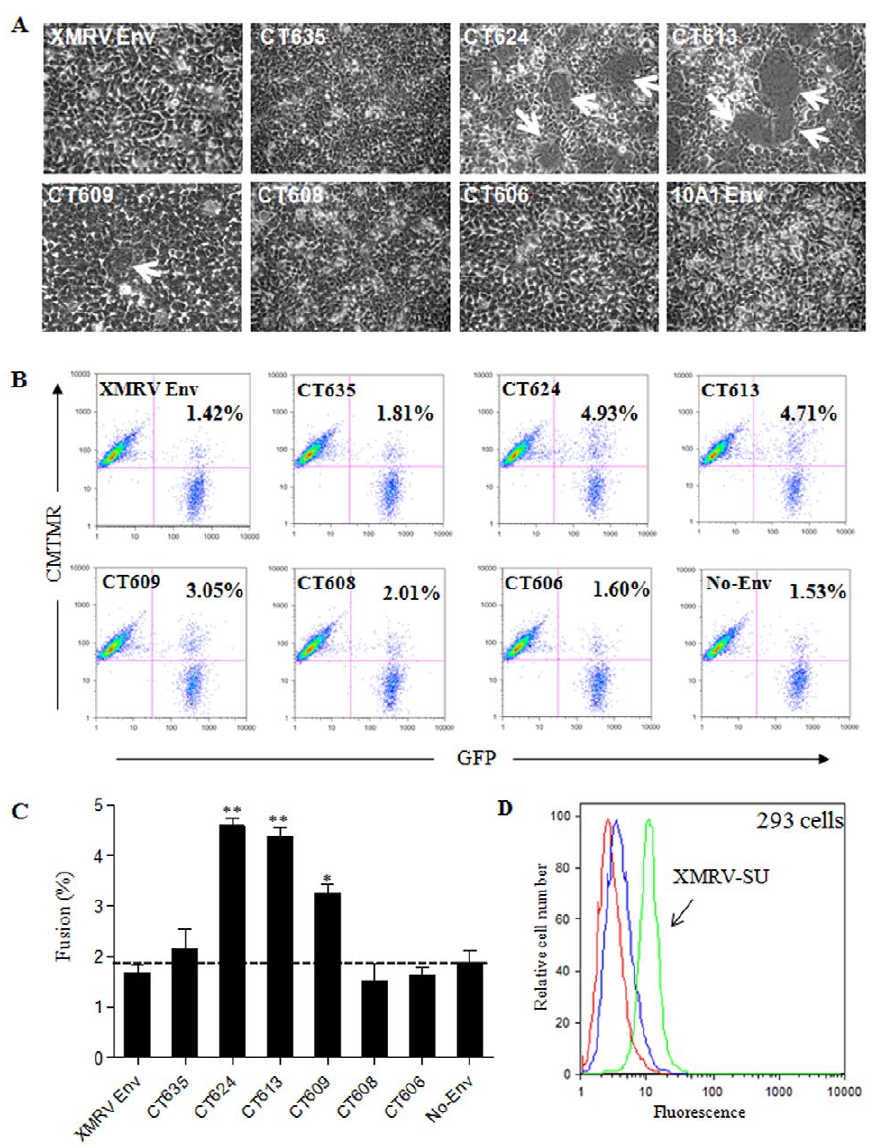
Figure 4. C-terminal truncation of XMRV Env in the CT activates its fusion activity. (A) Syncytium-induction assay. 293 cells were transiently transfected with plasmids encoding the indicated XMRV Env and photographed 24 h post-transfection. Arrows indicate syncytia. (B) Cell- cell fusion. Effector 293T-GFP cells expressing indicated XMRV Env or no envelope (No Env) were co-cultured for 6 h with CMTMR-labeled target 293 cells and analyzed by flow cytometry. Values shown represent the percentages of fused cells. (C) The fusion percentages (GFP + /CMTMR + ) of 3 independent experiments performed in duplicate were averaged ( 6 S.D.) and plotted. (D) Binding of XMRV SU to target 293 cells. XMRV SU (2 m g) was bound to cells for 4 h at 4 u C, stained with anti-human IgG FITC, and analyzed by flow cytometry. Red: unstained cells. Blue: secondary alone. Green: XMRV SU and secondary. A representative experiment is shown (n=4).